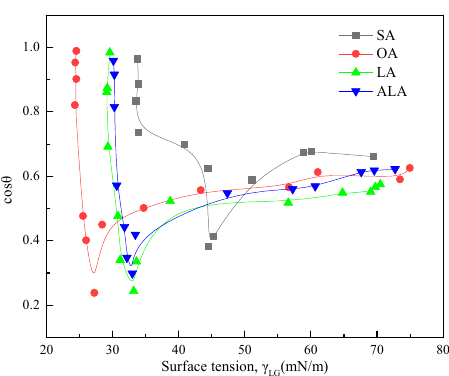
Figure 6. The variation of cos θ with γ LG of fatty acid solutions.